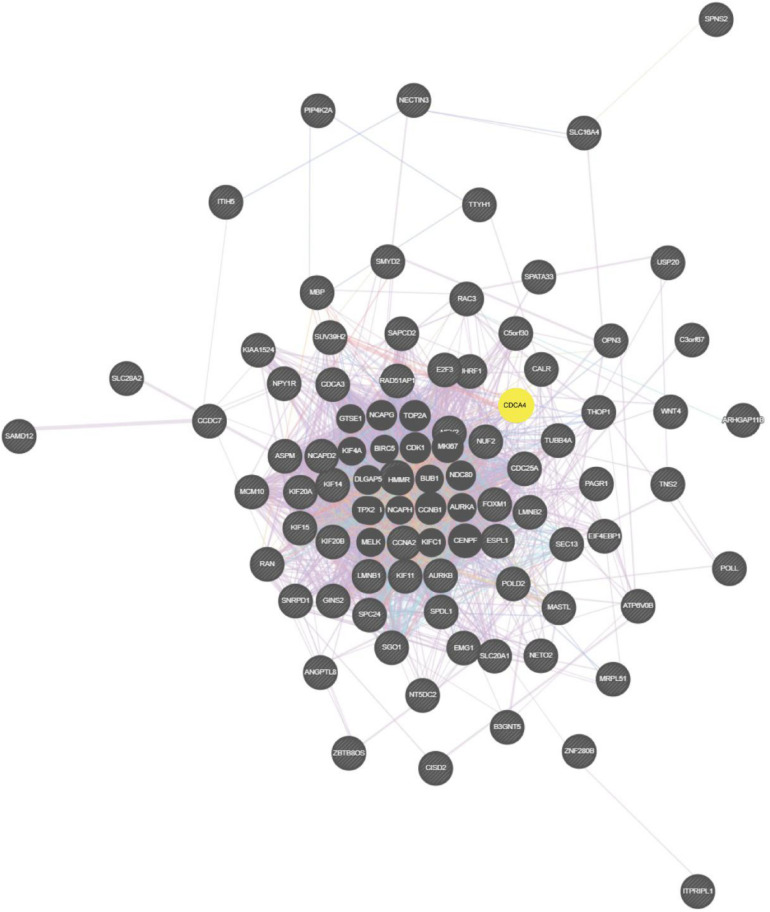
Totally, 90 aerobic exercise-related DEGs were included in PPI network. The nodes indicated proteins. The edges represented proteins’ interaction.